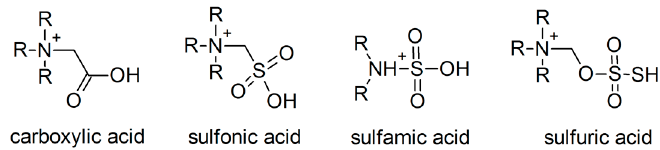
Figure 3. Overview of Brønsted acidic task-specific ILs (TSIL) cations. The picture shows the simplest representative of each kind of IL as variation in the length of the alkyl chain between the ammonium and the acidic functional groups are possible.